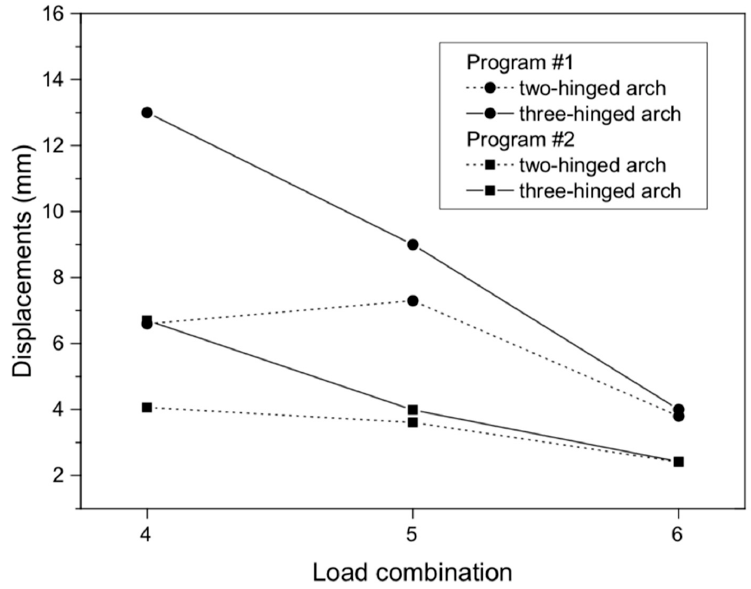
Figure 4. Displacements of masonry arch for various load combinations.